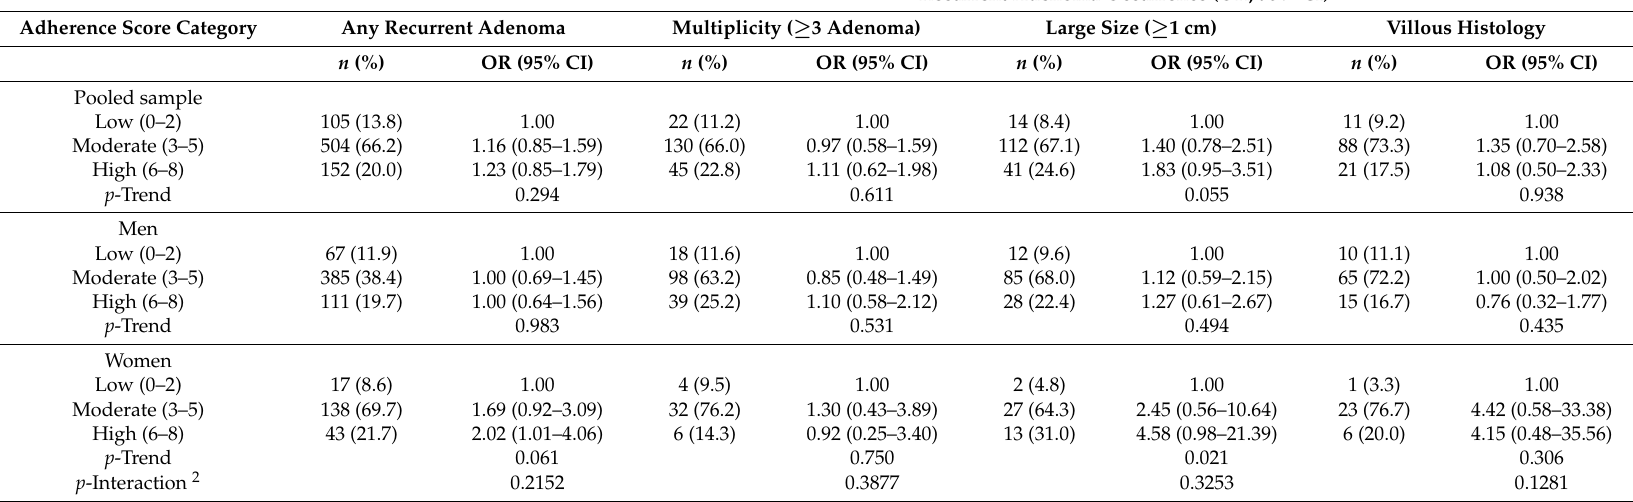
Table 4. Adjusted ORs (95% CIs) for the association between category of adherence and recurrent colorectal adenoma occurrence for pooled sample and by sex and